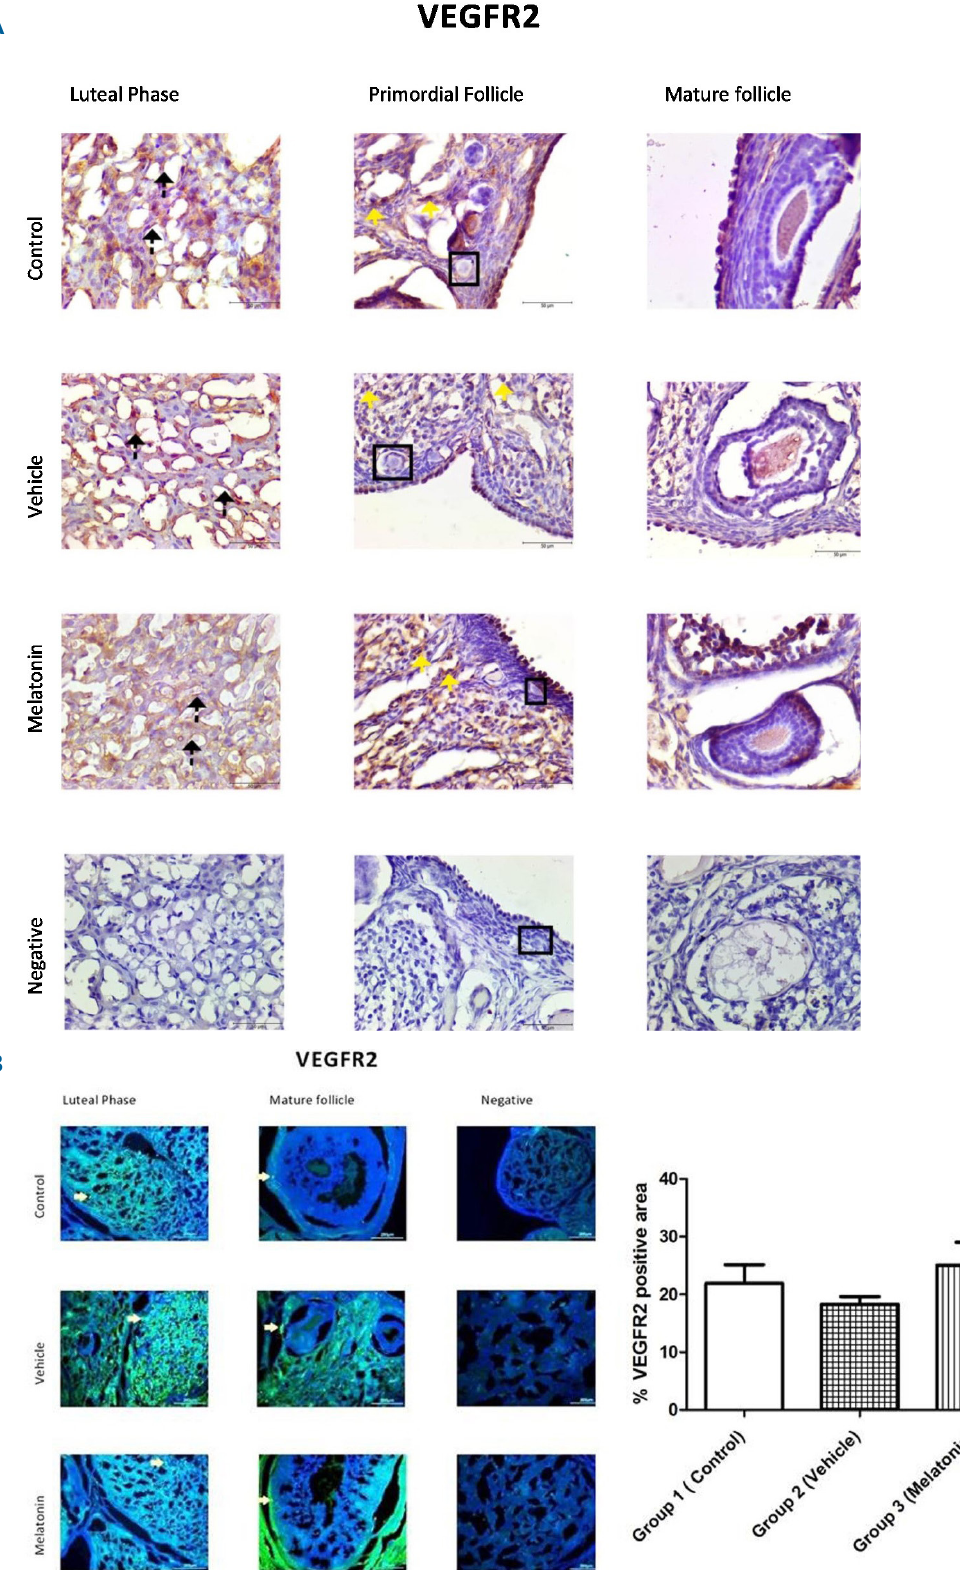
A: Immunohistochemical staining, B: Immunofluorescence staining. Immunoreactivity of VEGFR2 proteins in Group 1 (control), Group 2 (vehicle), and Group 3 (melatonin). Immunoreactivity of VEGFR2 in granulosa cells as indicated by yellow arrows can be seen in all of the groups. Data are displayed as the mean ± S.E.M.; n=15 rats/group. Figure 5 - Immunoreactivity of VEGFR2